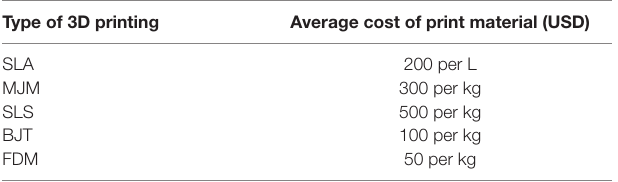
TABLe 4 | A summary of average raw material cost of each 3D printing technique. Type of 3D printing